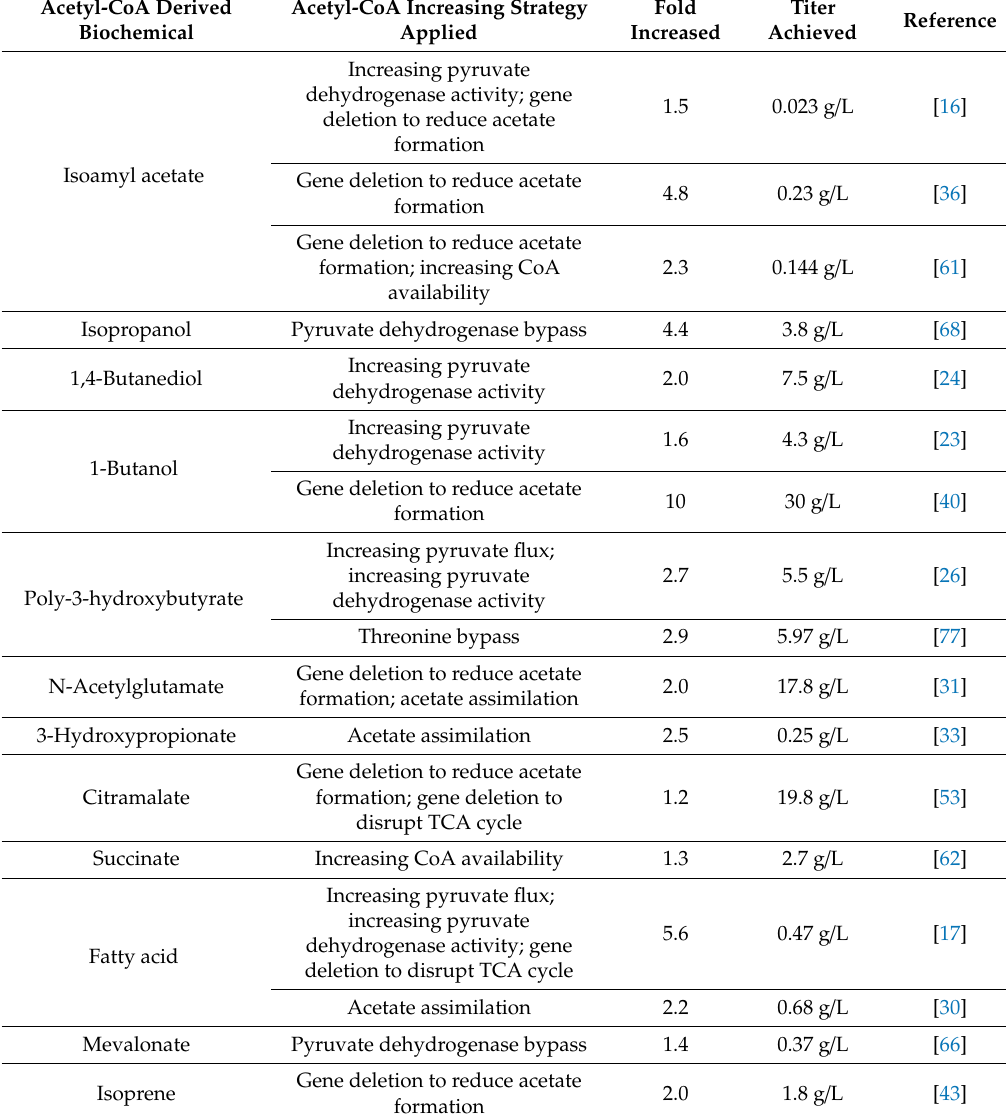
Table 2. The e ff ects of applying acetyl-CoA increasing strategy on biochemical production. Acetyl-CoA